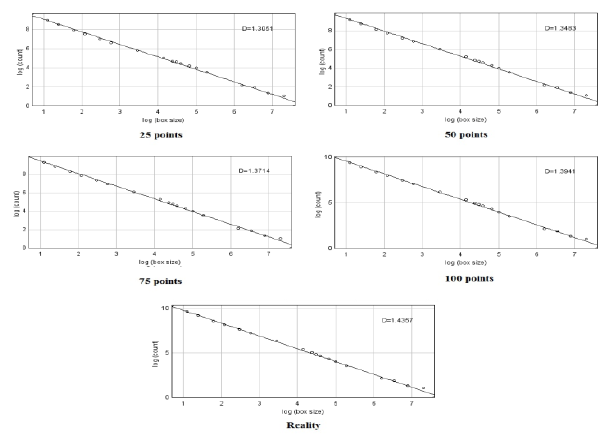
Figure 8. Fractal Dimension Values for Informal Transport Infrastructure Network (Simulation Runs and Reality)